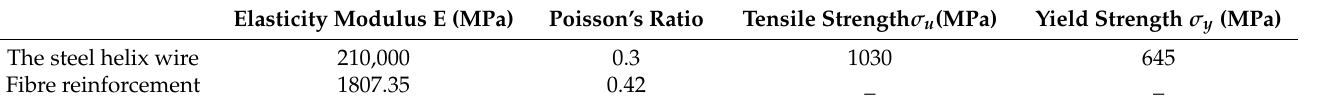
Table 2. Material properties.